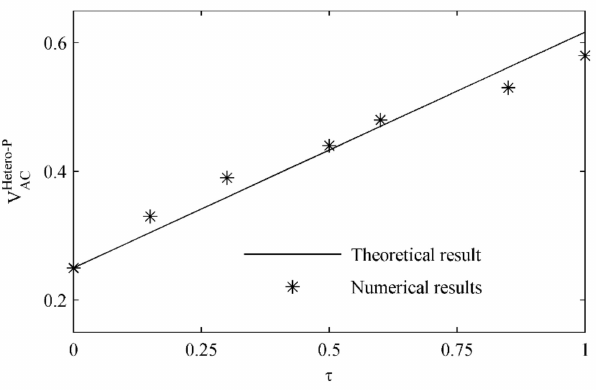
Figure 11. Variation of V AC threshold for heteroclinic bifurcation with τ for g p = 0.2. To depict the effect of delayed position feedback on controlling pull-in instability in details, the evolution of safe basin with the increase in τ is presented in Figure 12 where the delay is short, satisfying τ << τ + ( 0 ) . When τ = 0 (see Figure 12a,d,g), safe basins mean those of the uncontrolled system, which contain fractal boundaries, illustrating pull-in instability. With the increase in the delay τ , the fractal extent, namely the probability of pull-in instability, is obviously lessened, and the basin area enlarged, which can be